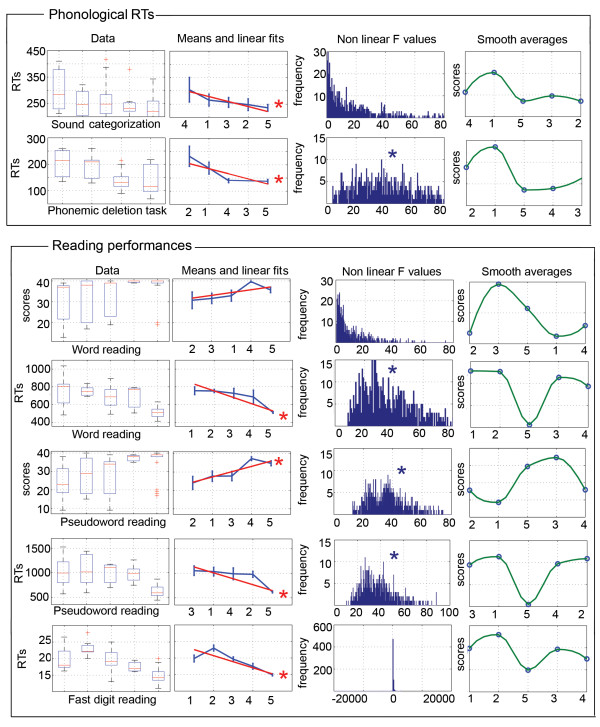
Illustration of subjects raw performances in the boxplots titled 'Data' (the red lines indicate the median, the blue boxes extend from the upper to the lower quartile values, the whiskers show the most extreme points within 1.5 times the inter-quartile range and the red plus signs indicate outliers) and bootstrapped performances with linear adjustments (graphic lines titled 'Means and linear fits'; vertical lines show the standard deviation of the bootstrapped means and the red lines the linear fits). Distribution plots titled 'Non linear F values' show the distributions of F values measuring the distances between the bootstrapped data and the bootstrapped regression lines. Non central distributions suggest non linear effects; significant effects are marked with a star. For all graphics, numbers below the graphics stand for the different groups: (1) LCD/LLN, (2) LCD/HLN, (3) HCD/HLN, (4) HCD/LLN, (5) Controls. Note that although linear adjustments can be observed based on the ranking of the means, the different behavioural tests have different ranking (in contrast to the behavioural tests illustrated on the figure 6). The last (right end side) graphics show the bootstrapped data (blue circles) with smoothed interpolated data (in green – piecewise cubic hermite interpolating polynomial).